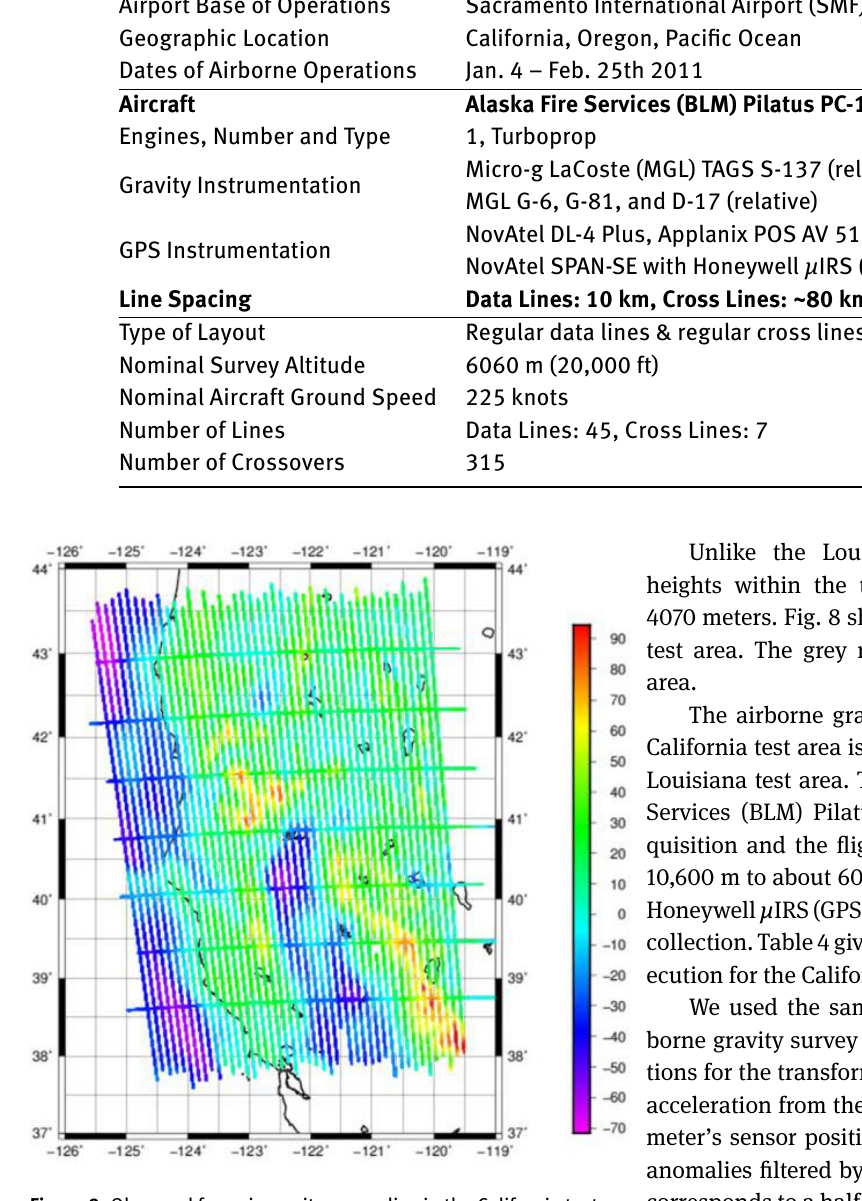
cific Time Zone, north of 40 ∘ latitude. This was the first (01) block of data completed in that region. Block PN01 is 650 km by 450 km, covering coastal areas of California and Oregon as well as ocean areas from 50 to 180 km off- shore GRAV-D Science Team (2012c). Fig. 7 shows the data coverage, plotted in Google